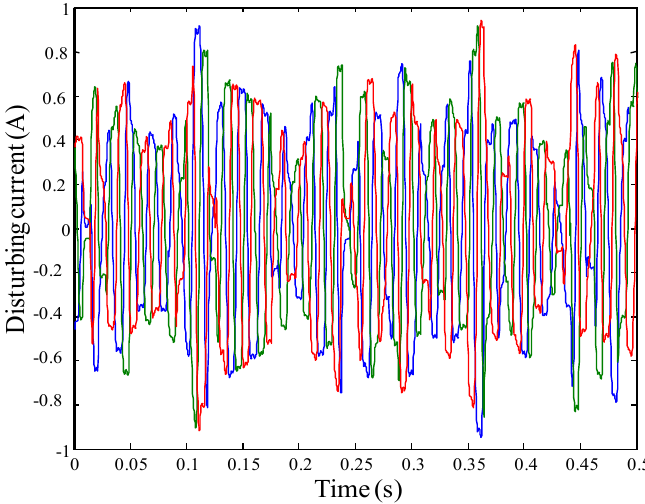
Figure 13. Disturbing three-phase current related to fast active and reactive power